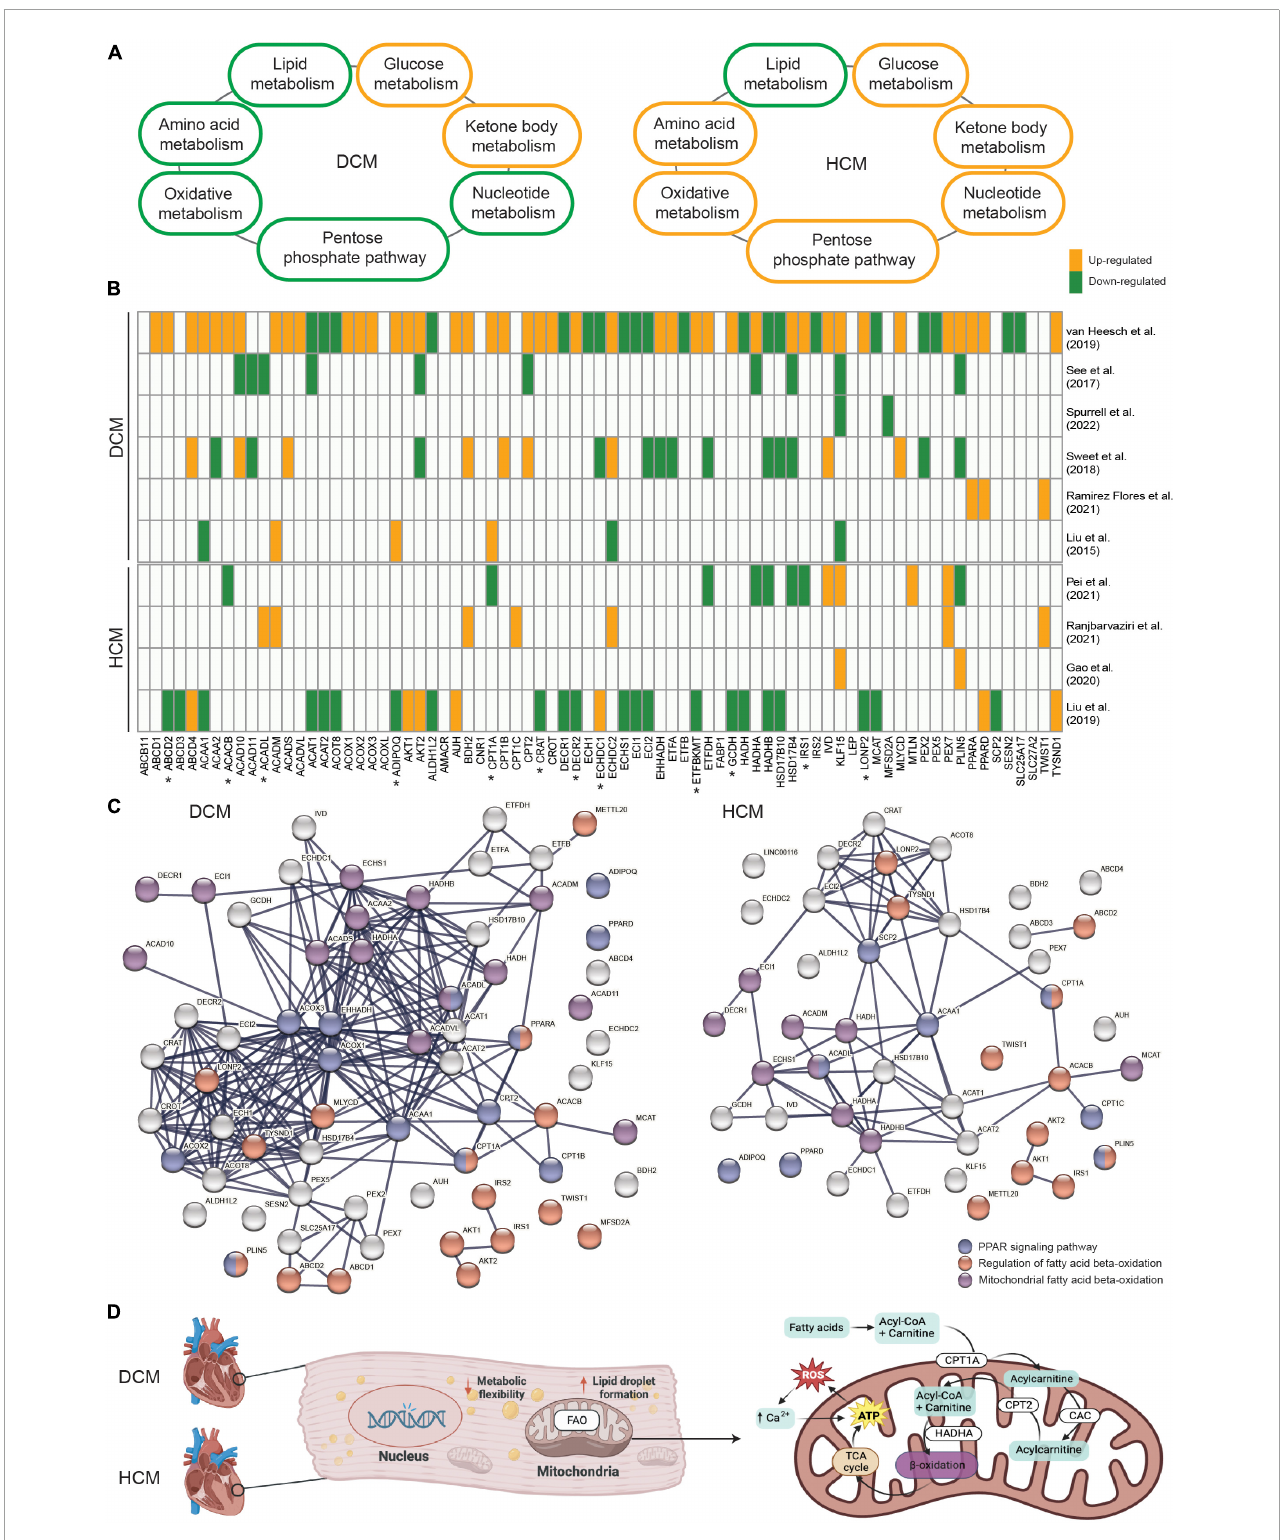
FIGURE1 (A) An overview demonstrating the alteration direction of seven main metabolic processes in dilated cardiomyopathy (DCM) and hypertrophic cardiomyopathy (HCM). (B) The involvement and expression pattern of 77 protein-coding genes associated with fatty acid beta-oxidation (FAO) in DCM and HCM. Up-regulated genes in DCM or HCM vs. the controls are shown in orange, and down-regulated genes are shown in green. Genes that were either not significantly altered or not shown in the related paper were shown in white. Genes with opposite alteration directions between DCM and HCM are indicated by “*”. (C) The enriched protein-protein interaction network in DCM and HCM, respectively. Highlighted genes involved in the regulation of FAO (red), mitochondrial-related FAO (purple), and the peroxisome proliferator-activated receptor (PPAR) signaling pathway (blue). (D) Schematic representation of mitochondrial FAO and its key regulators in inherited